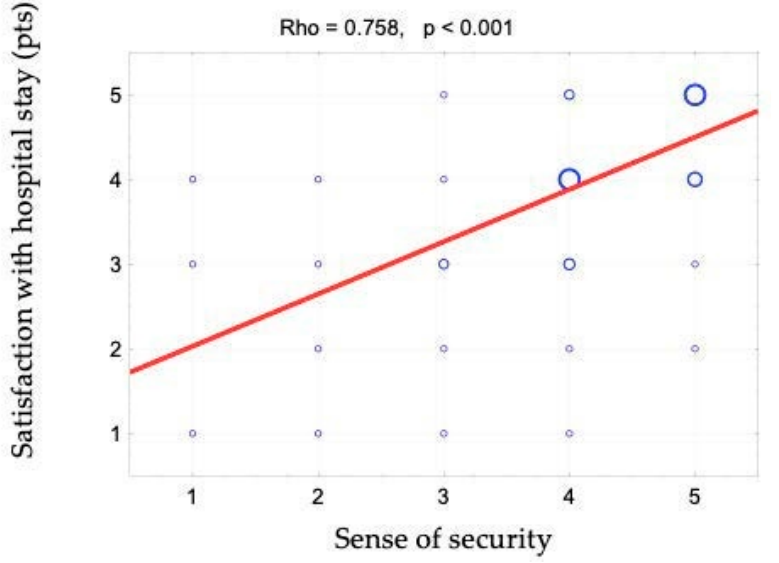
Figure 5. Correlation diagram between the sense of security (1—definitely not, 2—rather not, 3— partially, 4—rather yes, 5—definitely yes) and satisfaction with hospital stay and the value of Spear- man’s rank correlation coefficient (rho) .